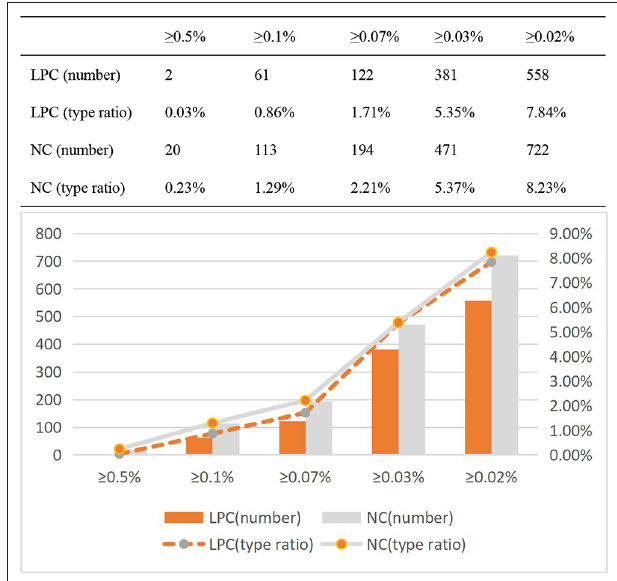
FIGURE 6 | Type ratio distribution of high frequency words of LPC and